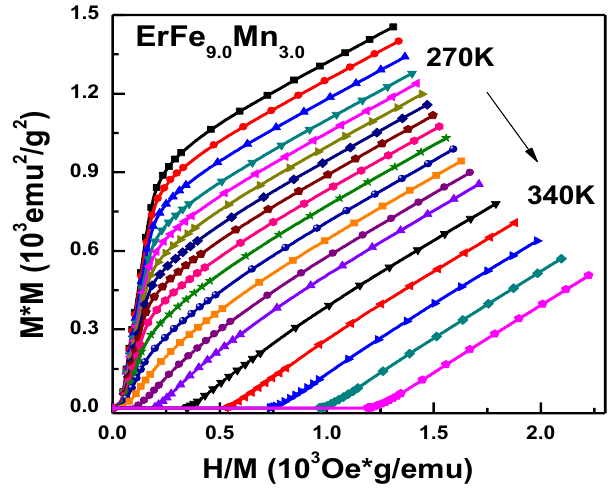
Figure 7. Arrott curve of ErFe 9.0 Mn 3.0